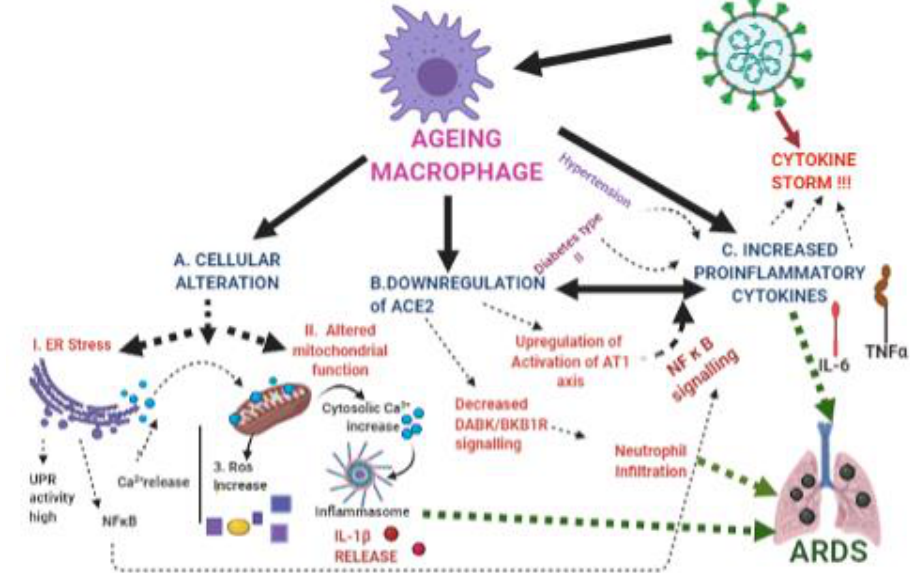
Figure 2. ACE2 downregulation in Aged macrophages: a putative pathway that leads to increased inflammation due to SARS-CoV-2 infection. Cellular pathway alteration leading to defective ER and Mitochondrial dysregulations are important markers in the pathway. The ER releases Ca 2+ which is taken by mitochondria leading to cytosolic Ca 2+ pool and ultimate inflammasome formation. Downregulation of ACE2 leads to neutrophil infiltration. Further increased levels in proinflammatory cytokines are consequences of severity of lung distress. An additional 15 cytokines namely M-CSF, 1L-10, IFN-α2, IL-17,1L-4, IP-10, IL-7, IL-1ra, GSF, IL-2, IFN-γ, IL- 1α, IL-2, HGF and PDGF- BB have been identified as biomarkers who increased level causes lung severity when 48 cytokine levels in blood were checked in a case study with 12 COVID-19 patients [53]. In a study conducted by Satis et al. with 58 individuals, it was found that the concentrations of Il-8 along with other inflammatory biomarkers had shown to worsen up the situations in SARS- CoV-2. The concentrations of IL-8 along with IL-6 was found to be higher in males than in females